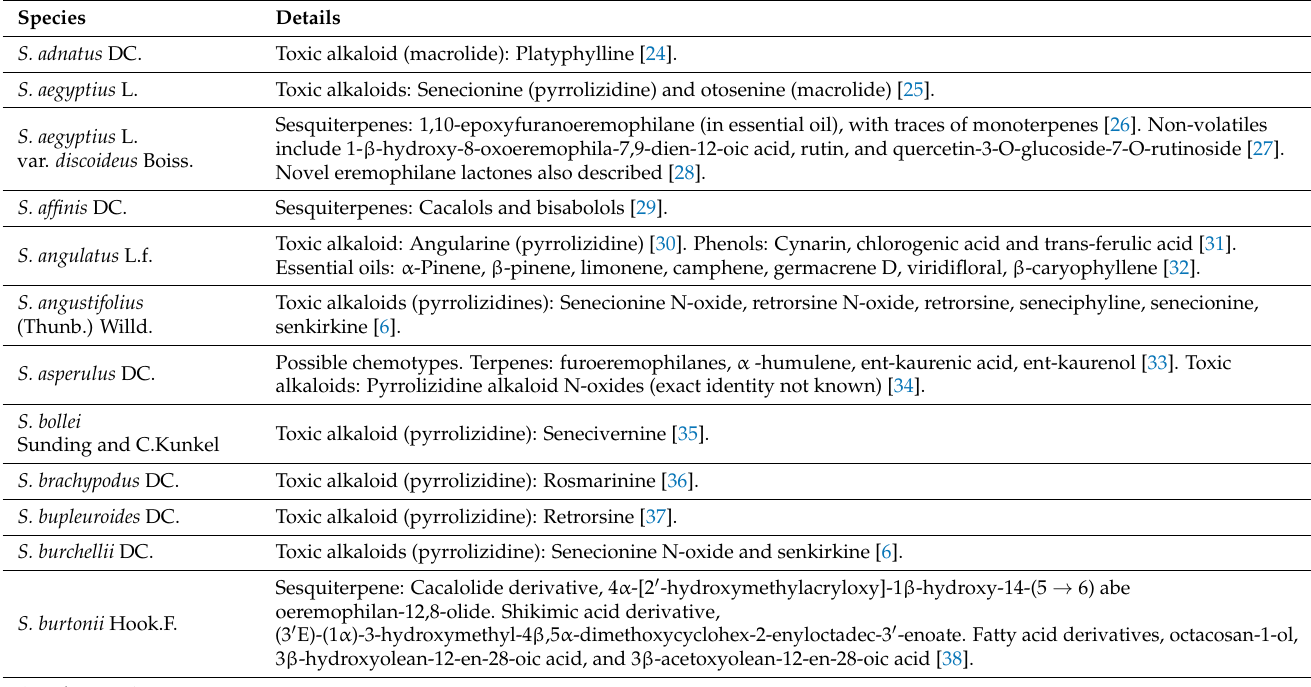
Table 2. Details of phytochemical studies of the 83 species (or subspecies) of Senecio in Africa, for which records could be